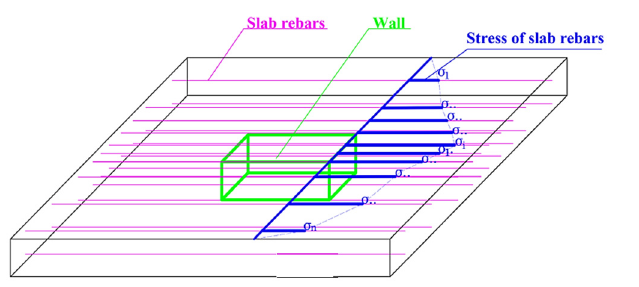
Figure 10. The tensile stress distribution of slab longitudinal reinforcement.